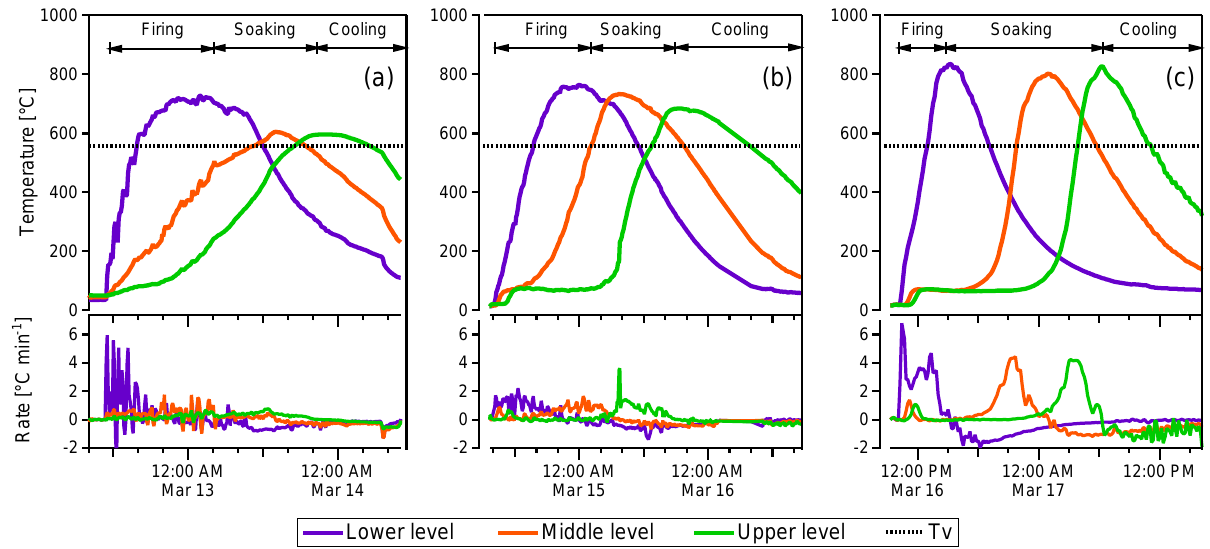
Figure 3. Temperature profiles (top panels) and temperature change rates (bottom panels) for (a) MK2, (b) traditional-campaign, and (c) traditional-fixed brick kilns for the lower, middle, and upper levels of the kilns. Horizontal dotted line represents T v , the temperature for the quartz inversion process (573 ◦ C). The figures also indicate the stages of burning, smoldering, and cooling for each kiln, as defined in the